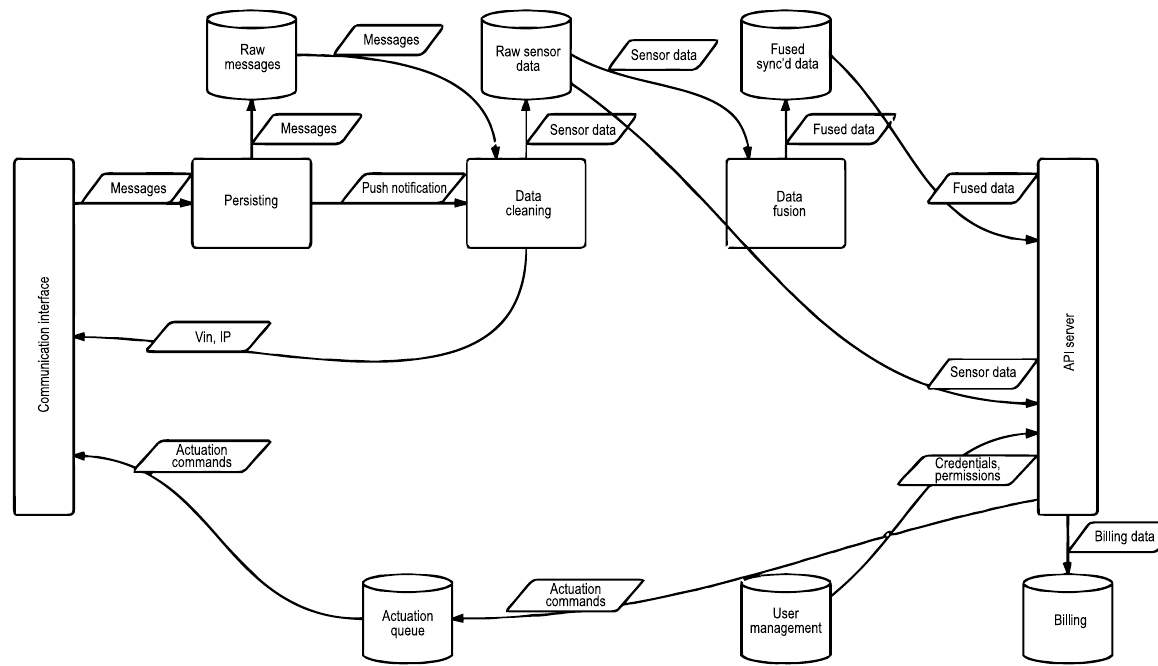
Fig. 5. Overview of the processing steps applied to incoming data packets by the CloudThink Data Server: cylinder is DB storage; square is a server; parallelogram is a process operation